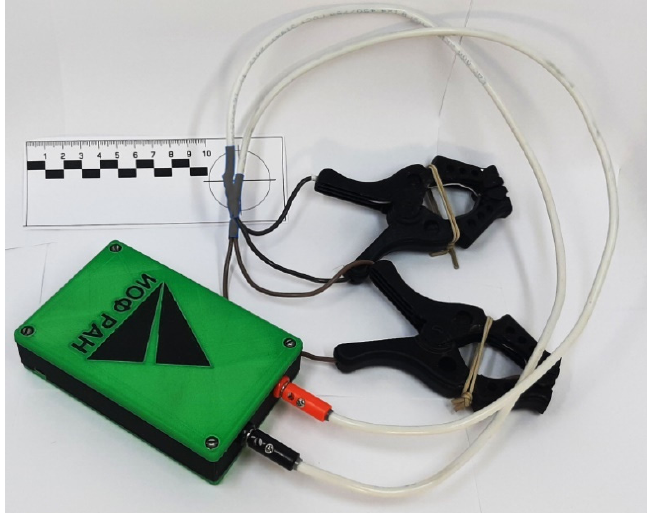
Figure 1. Appearance of the device for complex resistance (impedance) measurements.